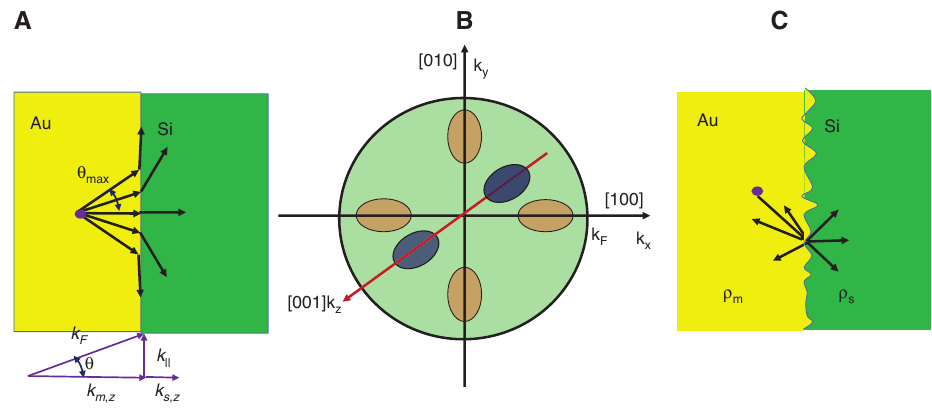
get injected. max